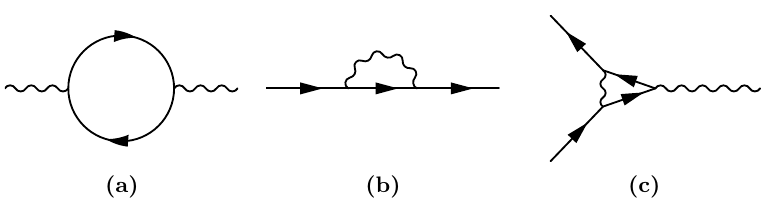
Figure 3. For the mixed dimensional QED: (a) photon one loop propagator correction; (b) fermion one loop propagator correction; (c) one loop vertex